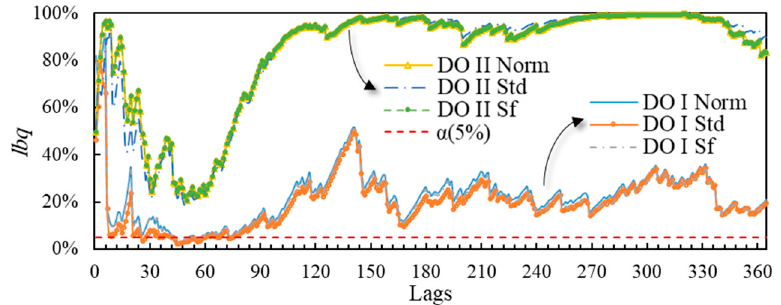
Figure 7. Ljung–Box (LBQ) test results for ARIMA models for the first 365 lags.